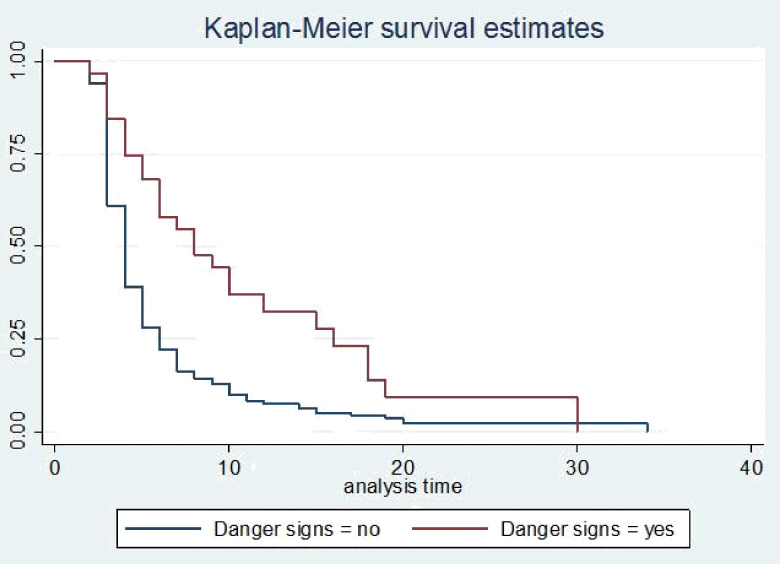
Kaplan-Meier survival estimate for time to recovery among SCAP children with danger signs.